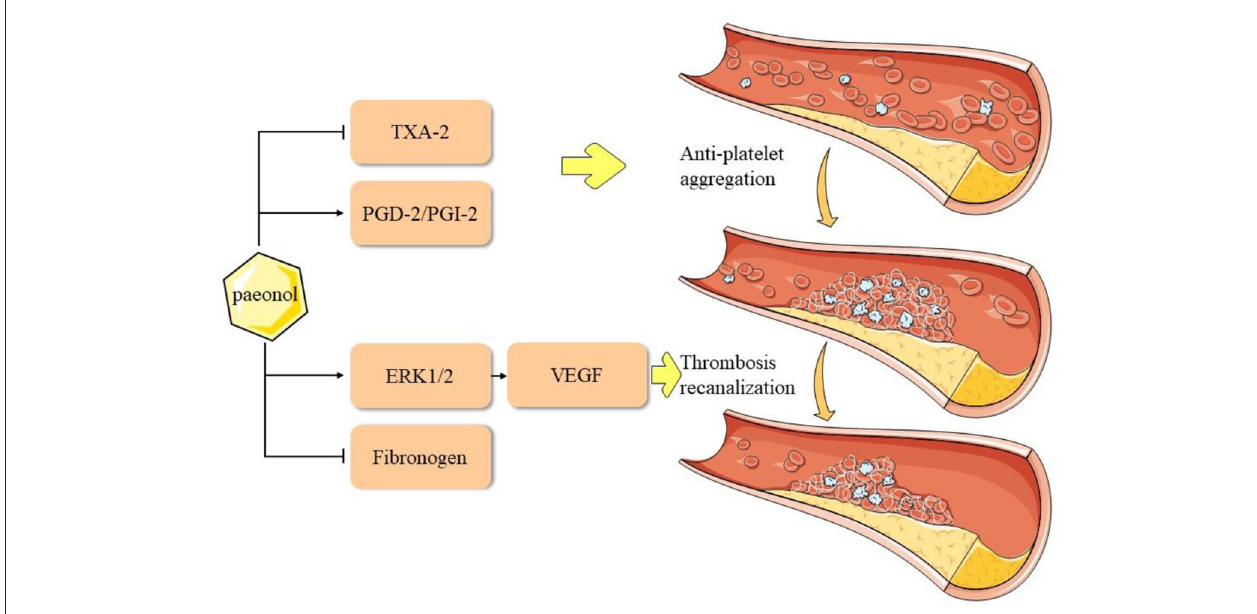
FIGURE 4 | Pharmacological mechanisms of paeonol in inhibition of platelet aggregation in atherosclerotic cardiovascular disease. ERK, extracellular signal-regulated kinase; PG, prostaglandin; PGI2, prostacyclin; TX, thromboxane; VEGF, vascular endothelial growth factor.